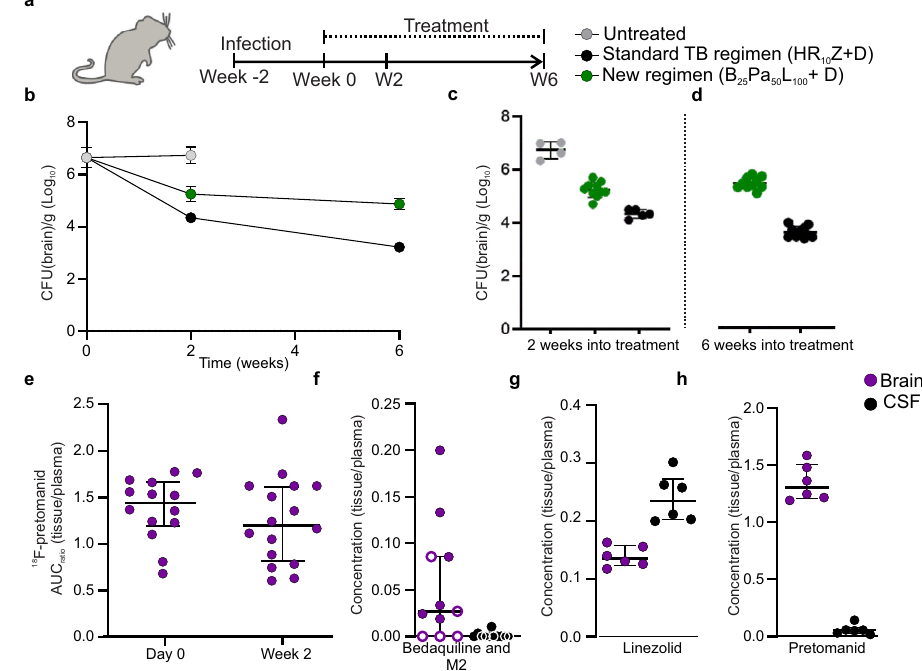
Fig.4|EvaluationofBPaLregimeninthemousemodelofTBmeningitis.a After two weeks of infection incubation (week 0), mice were randomly allocated